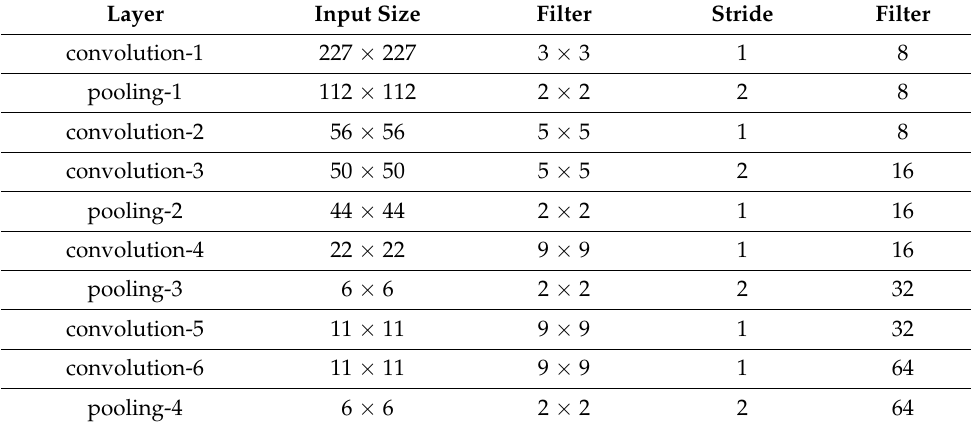
Figure 6. The proposed CNN model architecture. Table 4. The proposed CNN model layers.